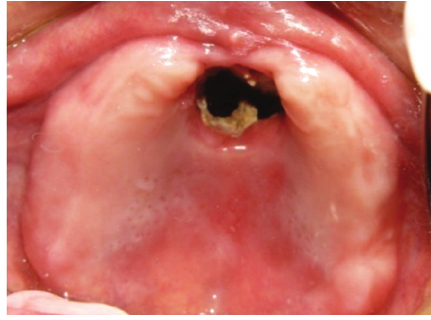
Figure 2: Intraoral view of maxillary defect.